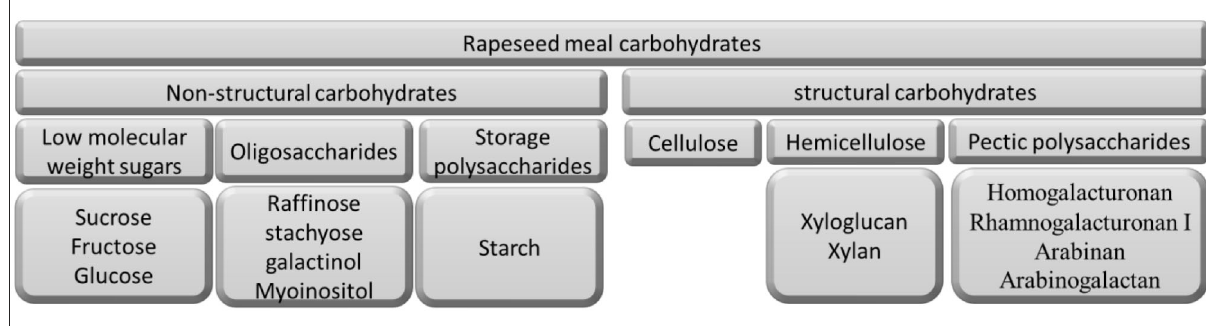
FIGURE1 Schematic representation of carbohydrates presented in rapeseed